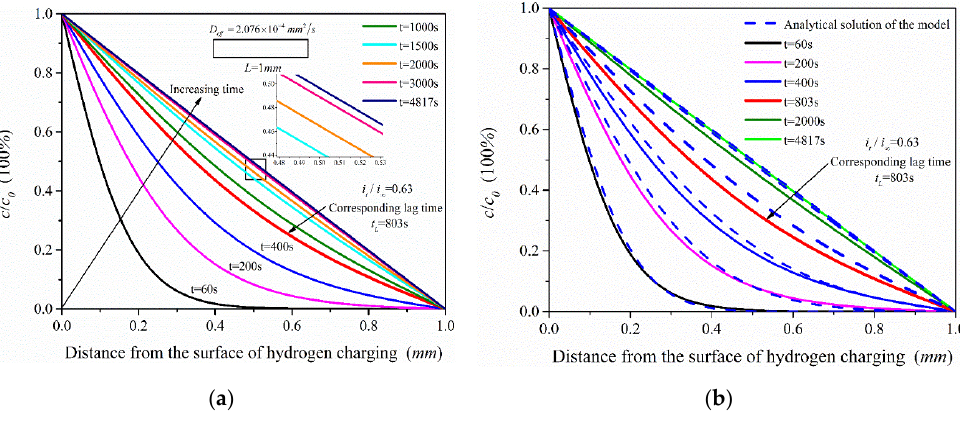
Figure 9. Hydrogen concentration distribution under different permeation time: ( a ) Finite element simulation results of the hydrogen permeation model; ( b ) Comparison of the analytical solution of the hydrogen permeation model and the simulation results.